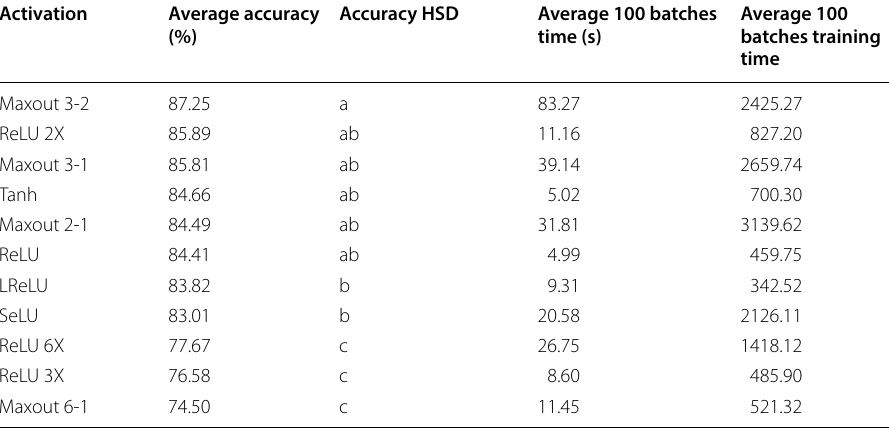
Table 9 Activation HSD test on face